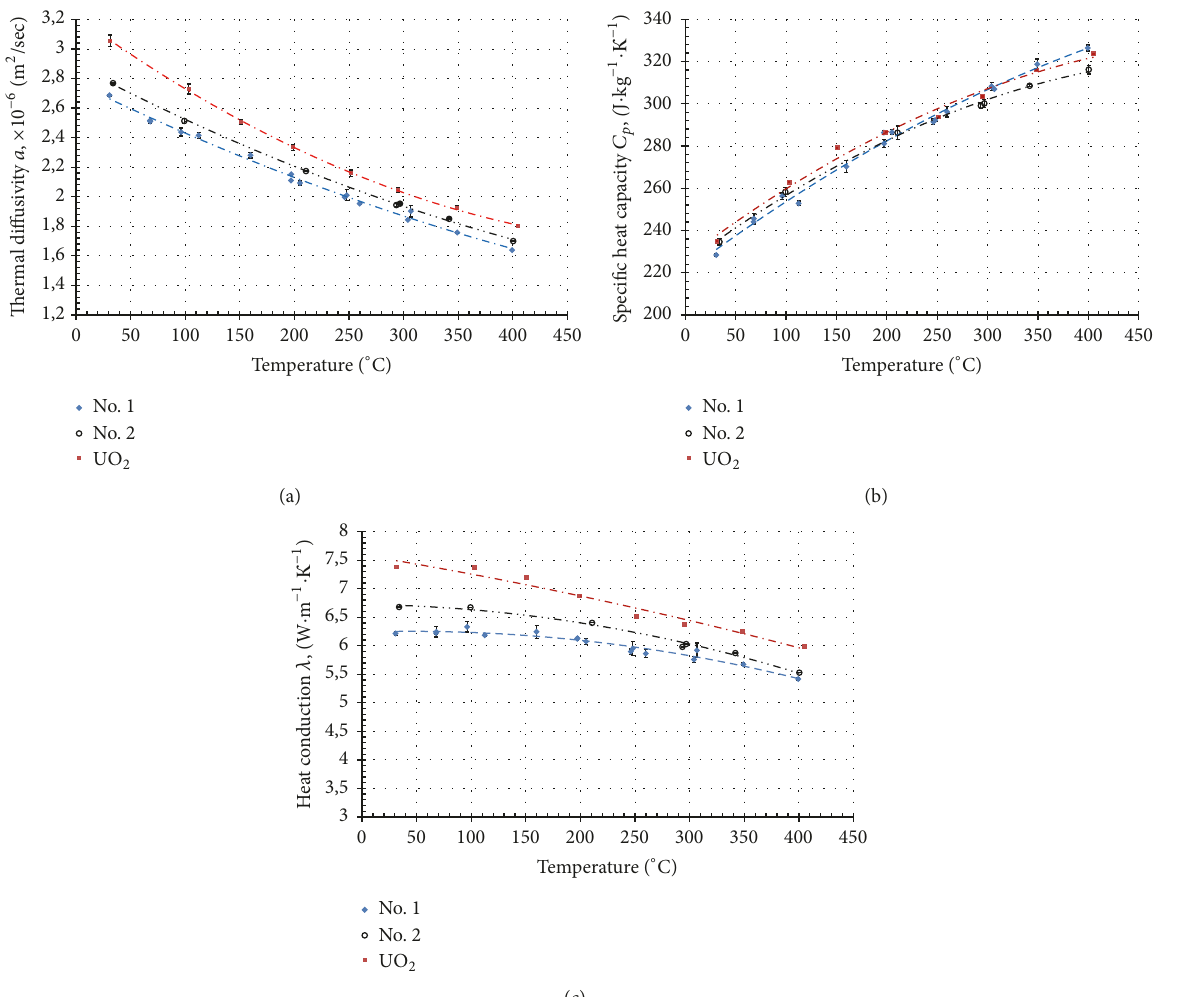
Figure 6: Comparing the results of TPP measuring of full-scale corium and sintered uranium dioxide